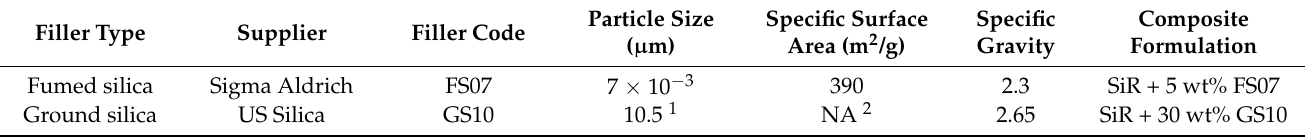
Table 1. Filler properties and prepared